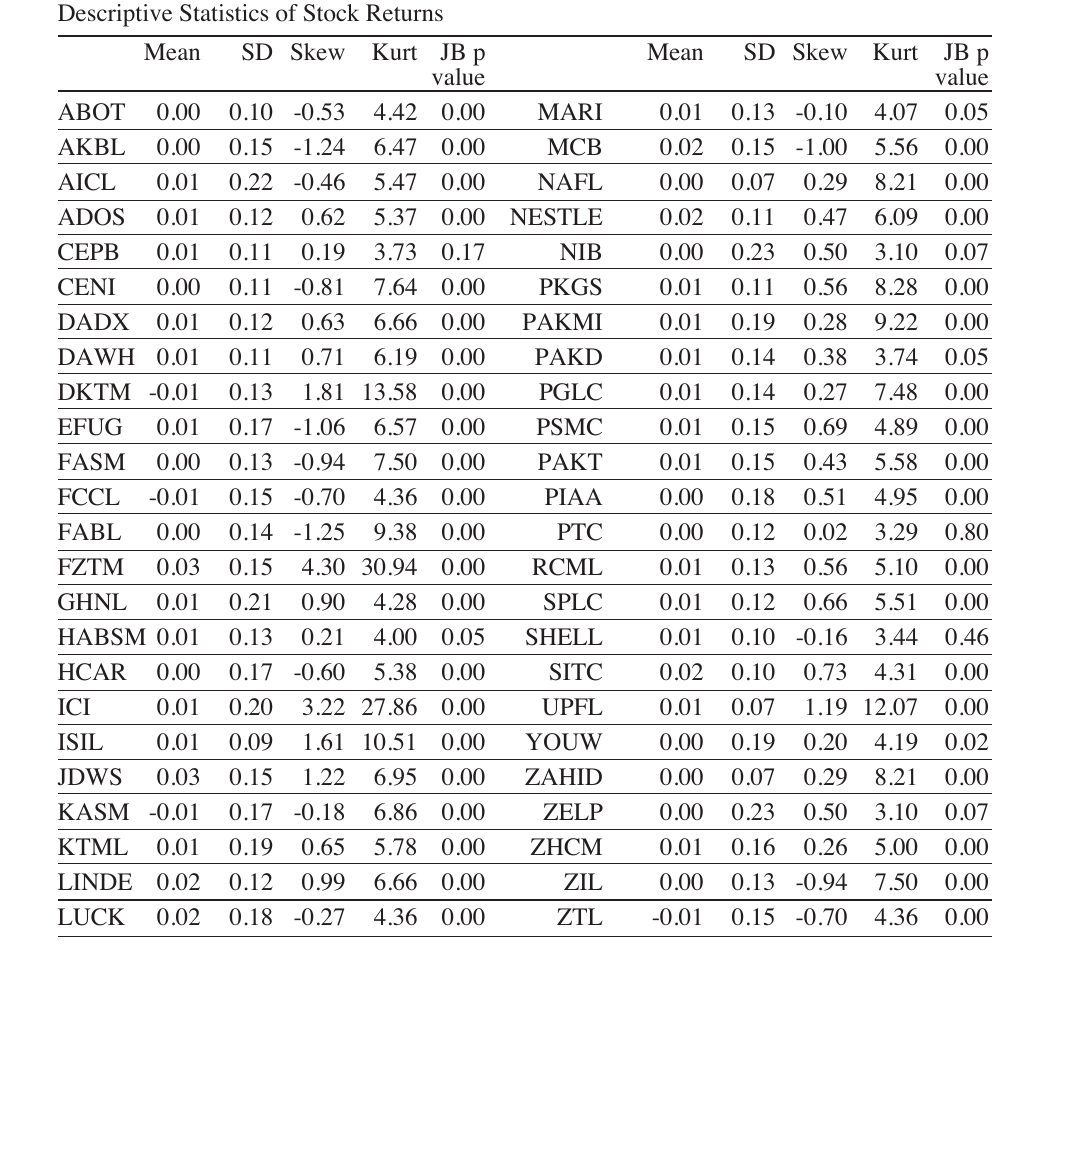
Descriptive Statistics of Stock